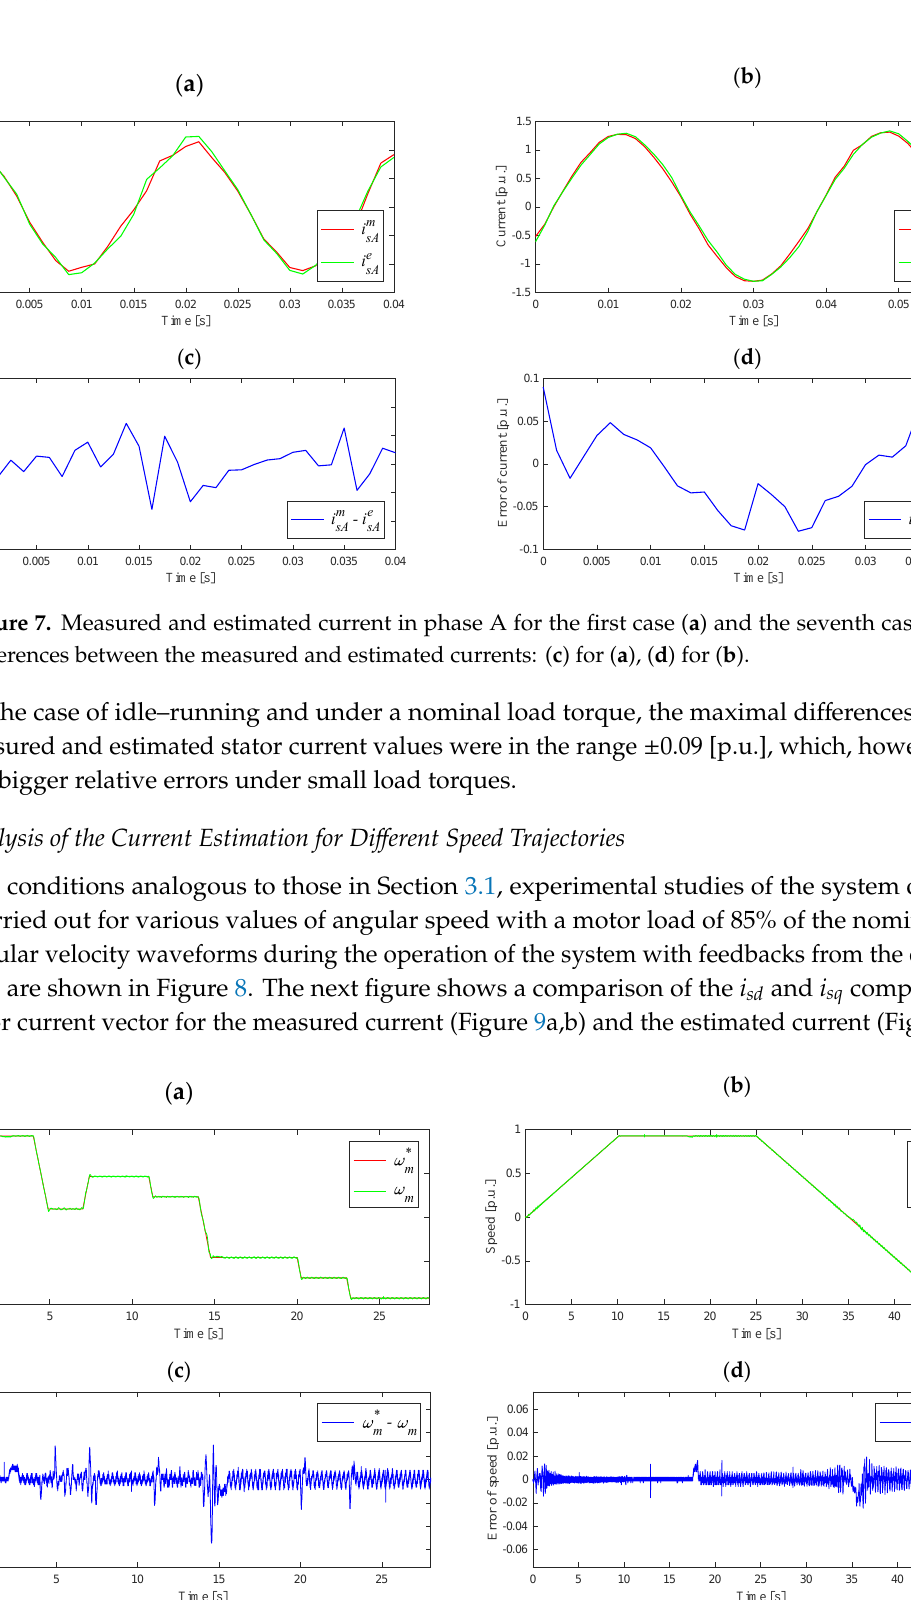
Figure 8. Reference and measured angular speed waveforms: ( a ) for various speed set points, ( b ) during slow start-up and reverse in the range ± ω mN , t L = 0.85 t LN , ( c ) speed error for Figure 8a, ( d ) speed error for Figure 8b.